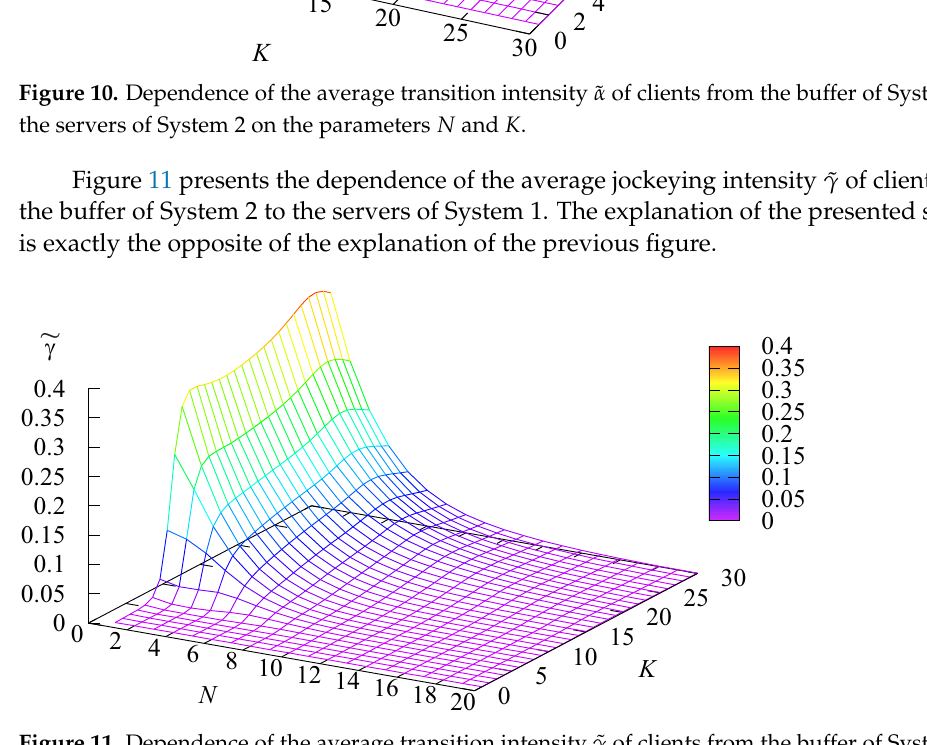
Figure 11. Dependence of the average transition intensity ˜ γ of clients from the buffer of System 2 to the servers of System 1 on the parameters N and K